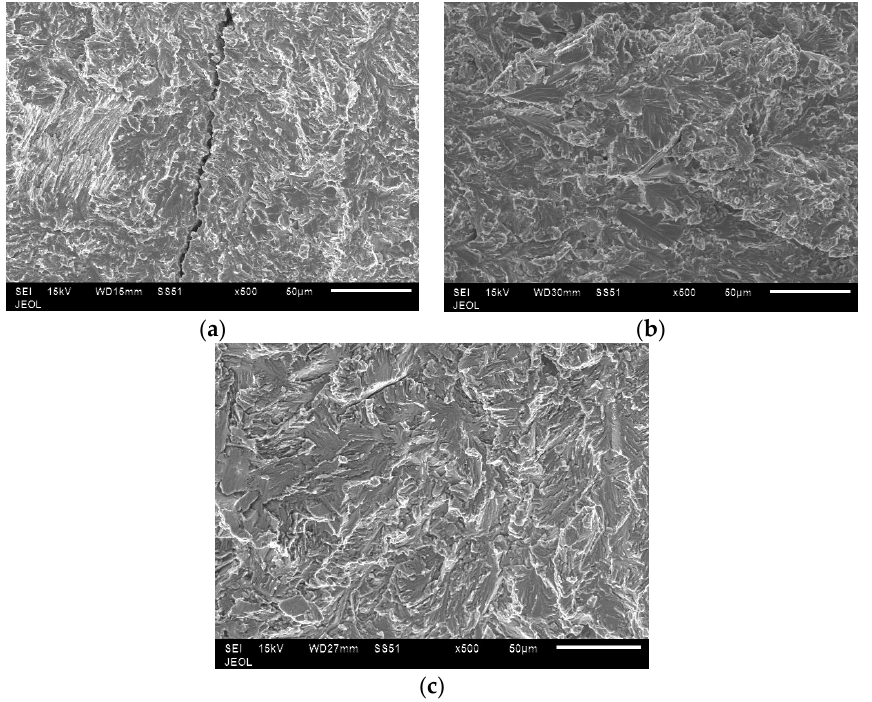
Figure 18. Fractographs of broken specimens in the tensile test; microcracks seen in the case of low energy ( a ); a mixed mode fracture in the medium energy condition ( b ); and lamellar delamination seen in the high energy condition ( c ).